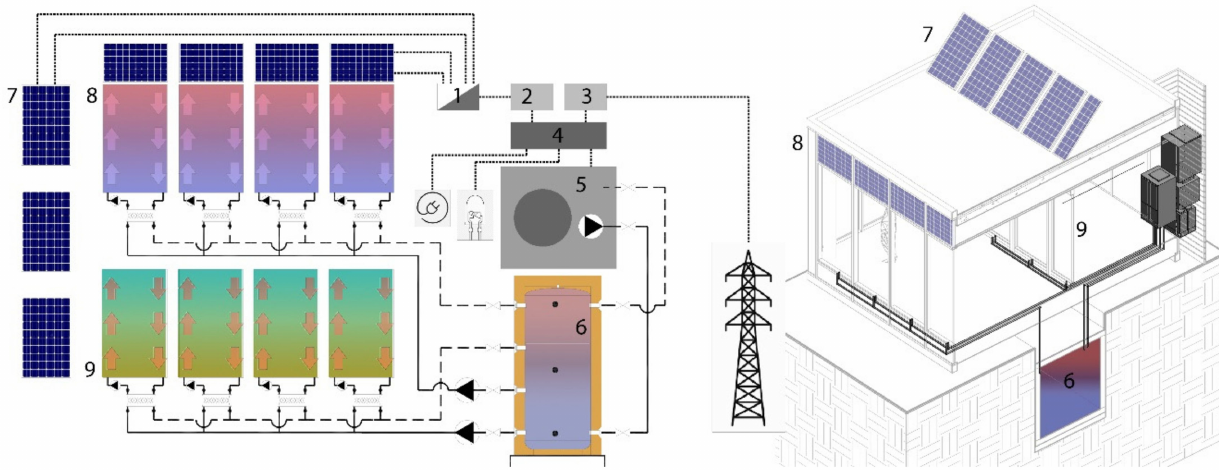
Figure 2. Description of Sophia’s prototype energy management system. 1. Inverter; 2. Production meter; 3. Utility meter; 4. Customer panel; 5. Electric loads (heat pump, lighting, power); 6. Buffer tank; 7. Roof PV open rack; 8. WFG facade with building integrated PV panels; 9. WFG interior